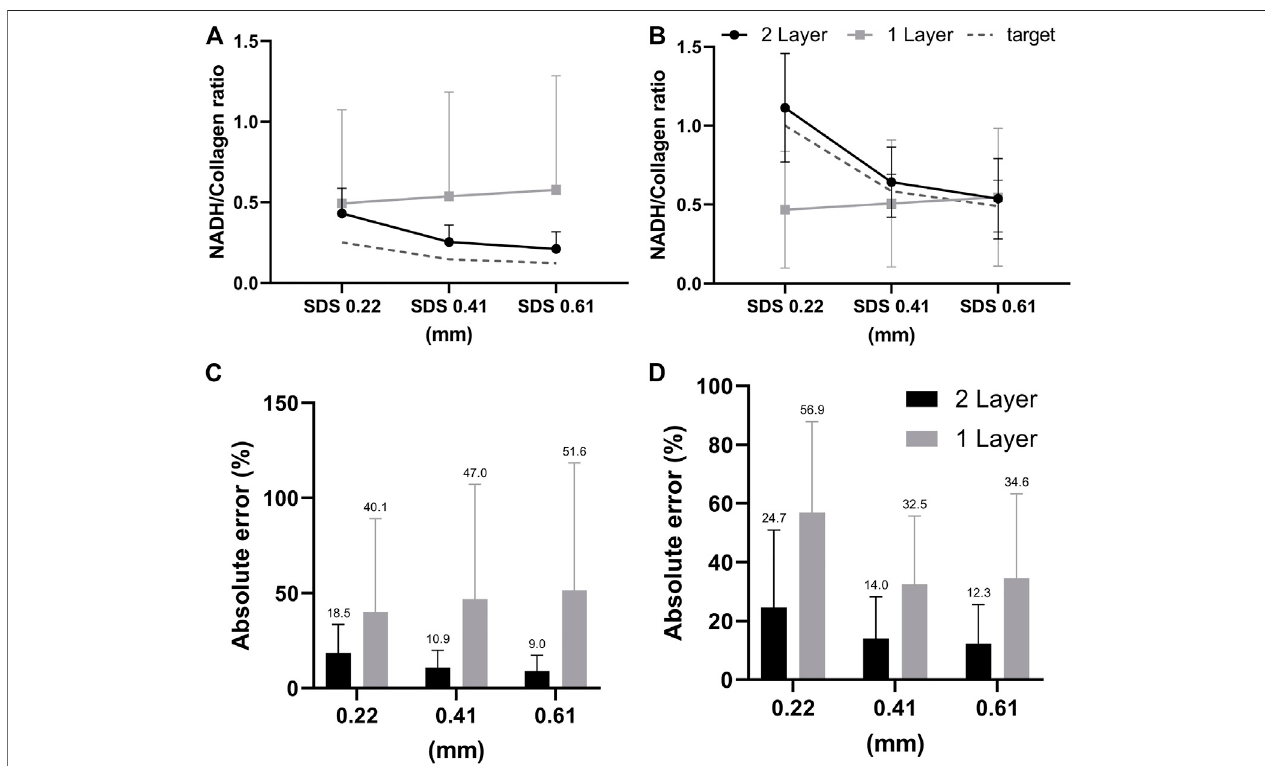
FIGURE7|(A,B) Comparisonsbetweenthetwo-layer andone-layermodelsinextractedcontributionofcollagentothetotaldetected fl uorescenceintensity.Gray dashed linesindicatethegroundtruthvaluesinthesimulatedtarget fl uorescencespectrawhichis80%in (A) and50%in (B) forSDS=0.22 mm. Panels (C,D) showthe absolute errors in extracted collagen contributions corresponding to panels (A,B) ,